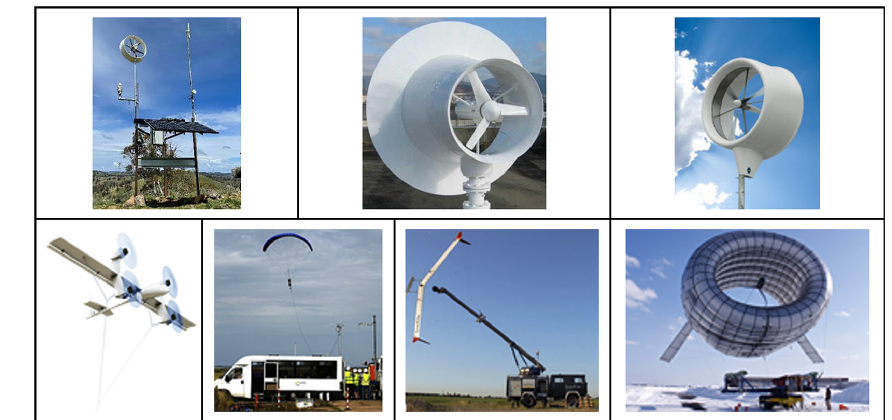
Figure 11. Currently proposed DAWT (upper row) and AWE kite archetypes (lower row). First row (from left to right): the Diffuse Energy Hyland 920 diffuser-augmented turbine as part of a remote power system for a communication tower (the 200W turbine has a maximum diameter of 0.92m; photo supplied by Dr Joss Kesby), HAWT with flanged diffuser (Ohya et al., 2008), DonQi urban windmill (photo credit: DonQui Global). Second row (from left to right): cross-wind or fly-gen (a.k.a. drag-power) devices (image credit: Windlift), ground-gen (a.k.a. lift power) flexible kite (photo credit: KPS), ground-gen rigid kite (photo credit: Ampyx Power), aerostat ducted wind turbine (photo credit: Altaeros).